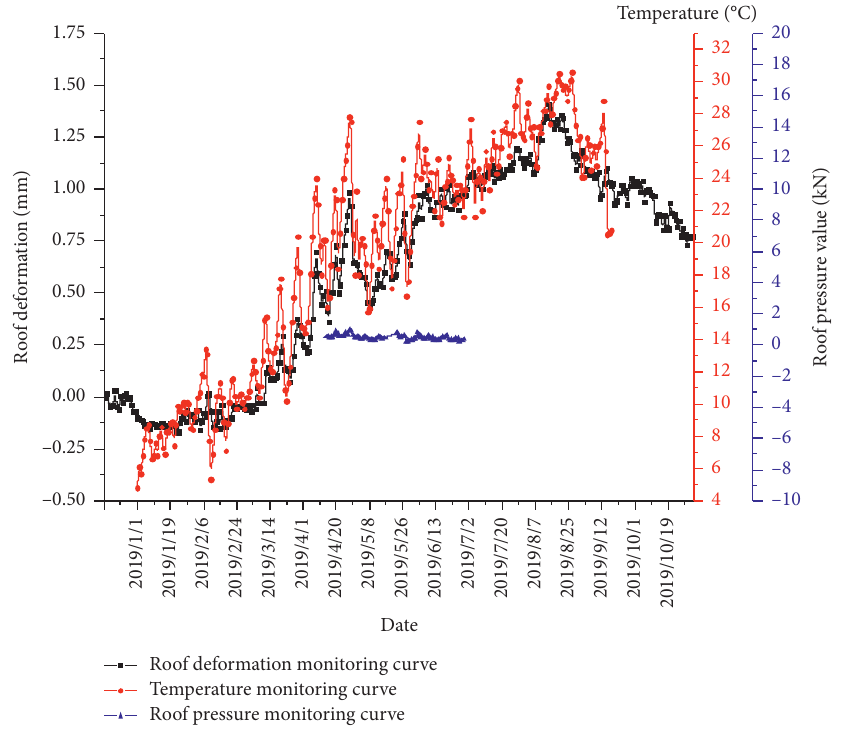
Figure 9: Relationship between roof displacement and temperature.